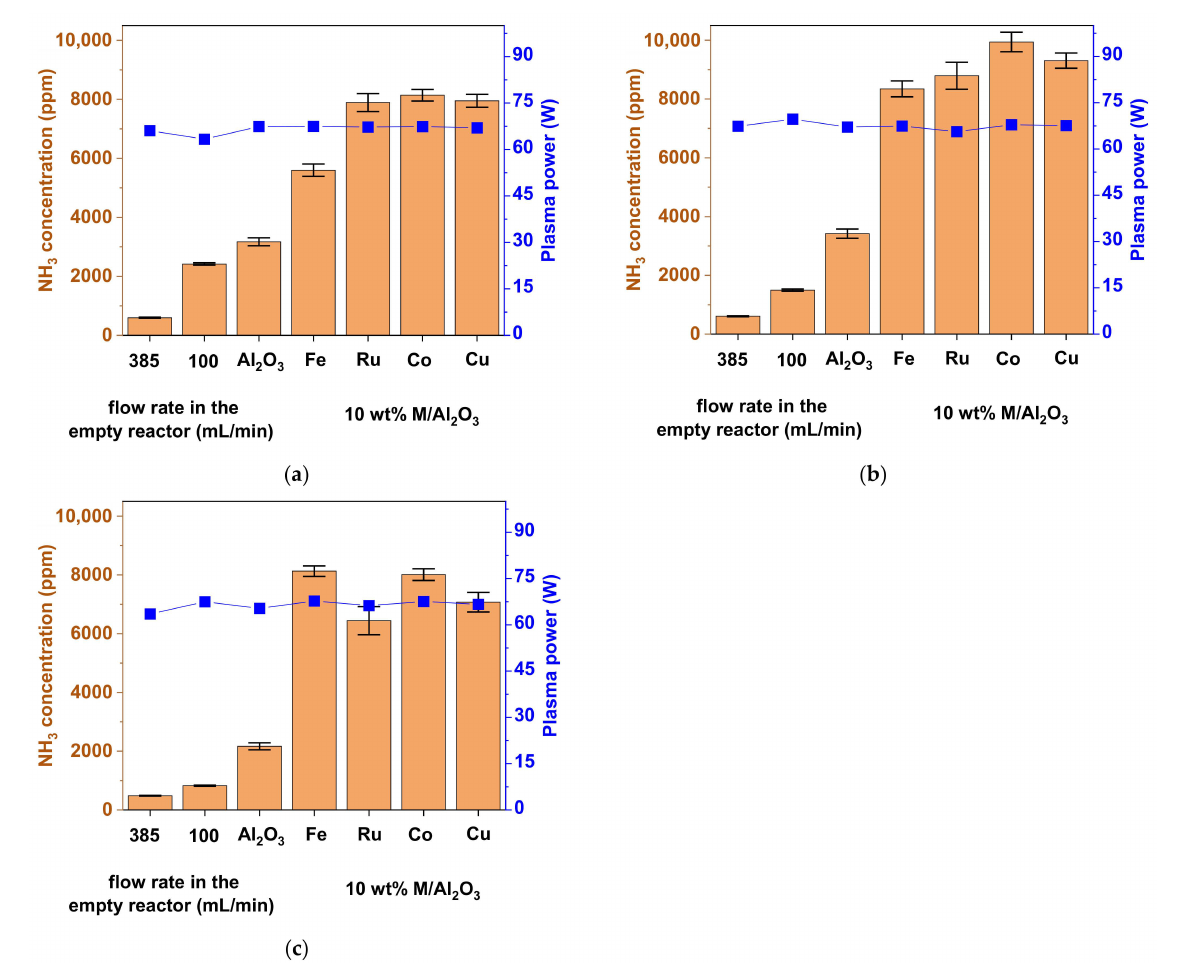
Figure 5. Concentration of NH 3 obtained from N 2 and H 2 in the plasma-catalytic reaction within the DBD reactor, for an empty reactor and a packed reactor with pristine Al 2 O 3 beads, and Al 2 O 3 beads impregnated with 10 wt% Fe, Ru, Co, or Cu catalyst. The empty reactor was used with two different feed gas flow rates: 385 and 100 mL/min, to have the same residence time and same mass flow rate, respectively, as the packed reactor. The experiments were performed with three H 2 :N 2 ratios: ( a ) 3:1; ( b ) 1:1; ( c ) 1:3. The error bars denote the standard deviation between three independent